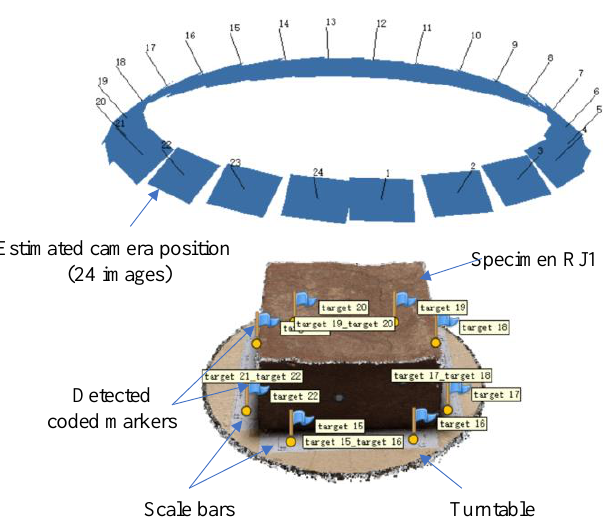
Figure 6. A 3D model of RJ1 reconstructed by Metashape software.